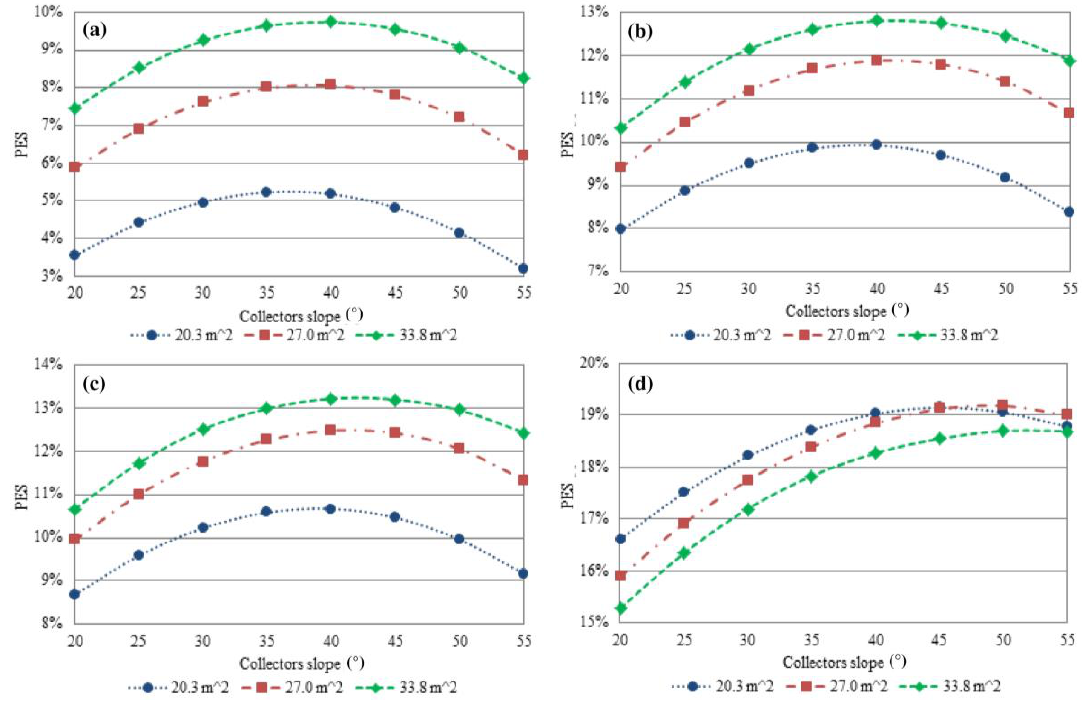
Figure 8. Primary energy saving of the ASs with 0% of solar thermal energy surplus used and flat-plate collectors in the four alternative configurations: ( a ) Scenario A; ( b ) Scenario B; ( c ) Scenario C; and ( d ) Scenario D. Energies 2016 , 9 , 724